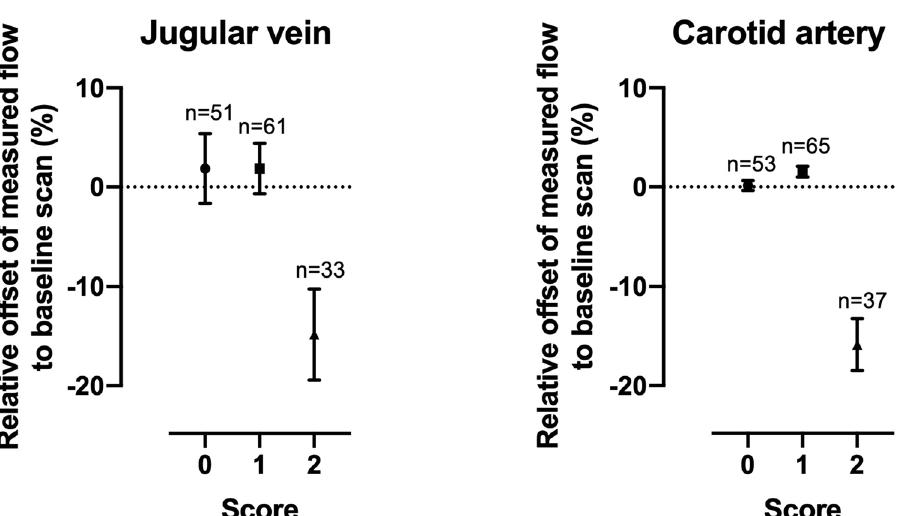
Figure 5. Impact of motion on flow-measurements in images with different scores. The relative deviation in percent (offset) of a flow measurement compared to its reference (baseline) scan without motion as a function of the given score for its referring image. The dots display the mean ± 95% Confidence Interval. The number of scans rated with an individual score is displayed above the referring score. In both types of vessels, scans scored with a score of two had significantly lower flow compared to scans with a score of zero (p < 0.0001). Scans with a score of one showed no significant bias in their flow measurements compared to scans with a score of